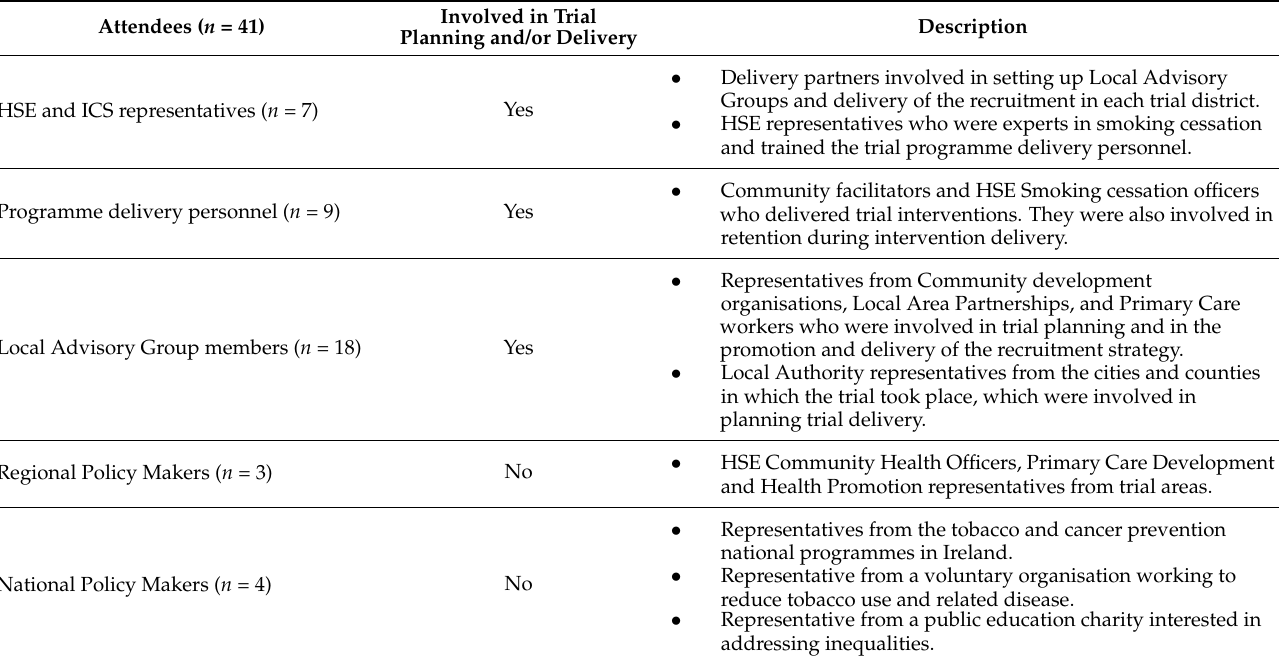
Table 1. List of workshop participants including their professional role and involvement in trial conduct. Involved in Trial Attendees ( n = 41) Planning and/or Delivery